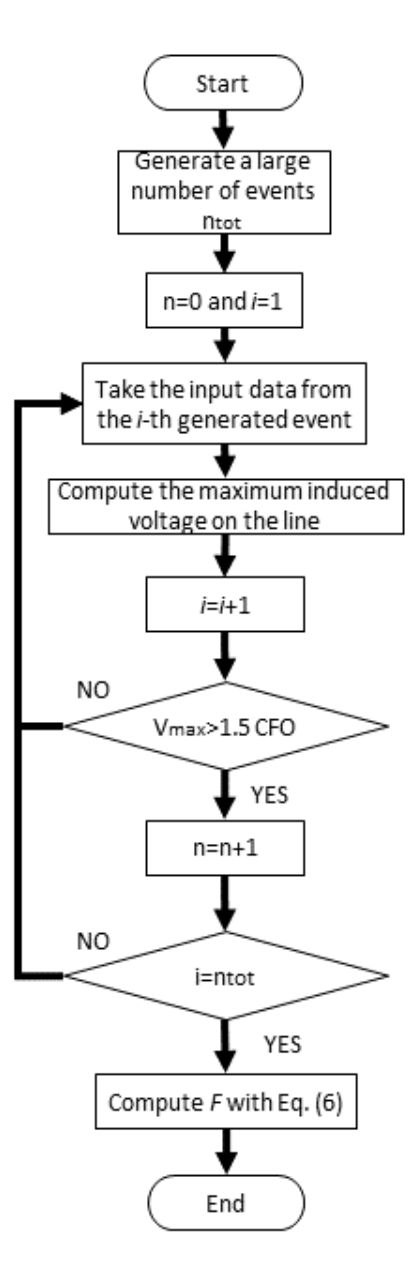
Figure 1. Flowchart of the lightning performance